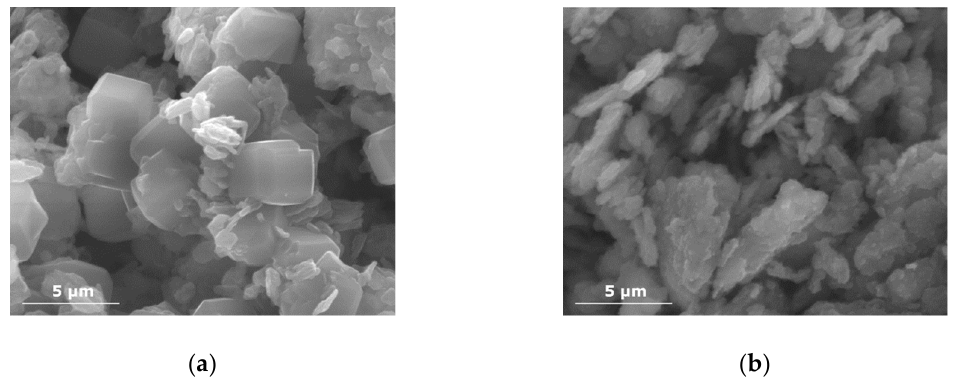
Figure 4. The microstructure of metakaolin-based composites: ( a ) MK2 ; ( b ) MK5 .